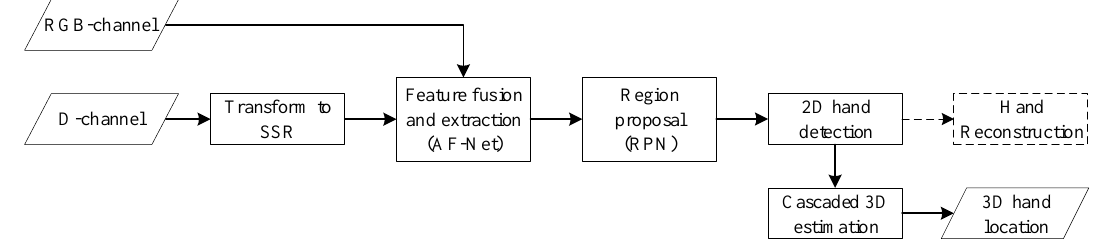
Figure 5. The flowchart of our 3D hand detection approach.